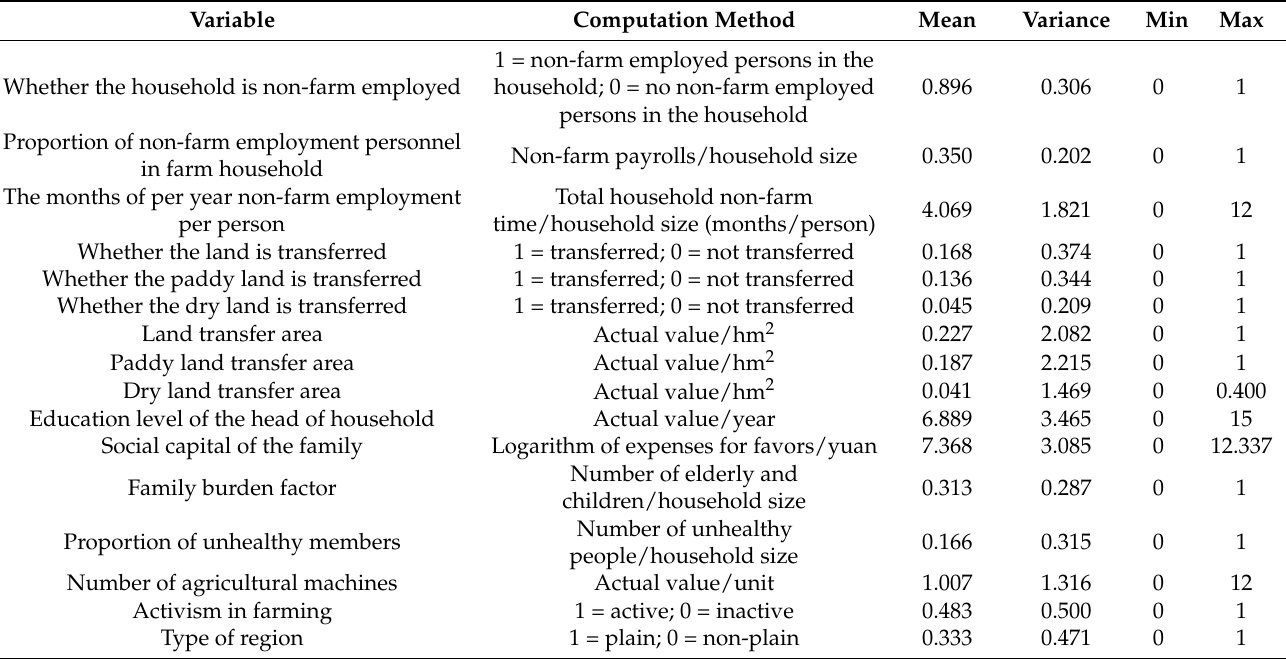
Table 1. Variable definitions and descriptive